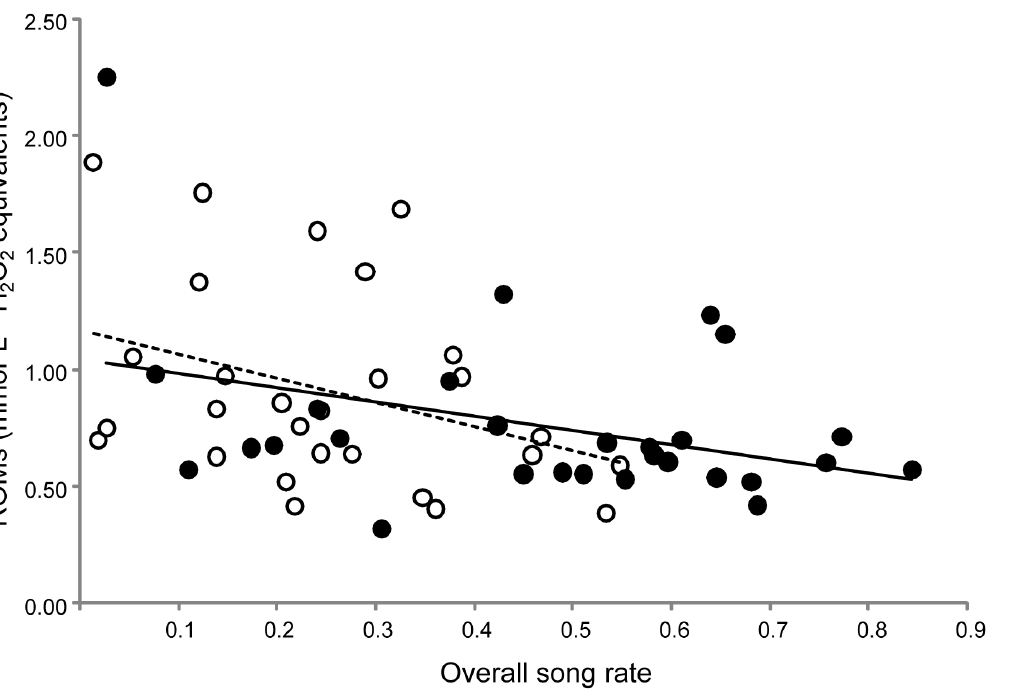
Fig. 5. Relationship between overall song rate and oxidative damage in the two treatments on day 30. Full dot/solid trendline for Caro-group and open dots/dashed trendline for